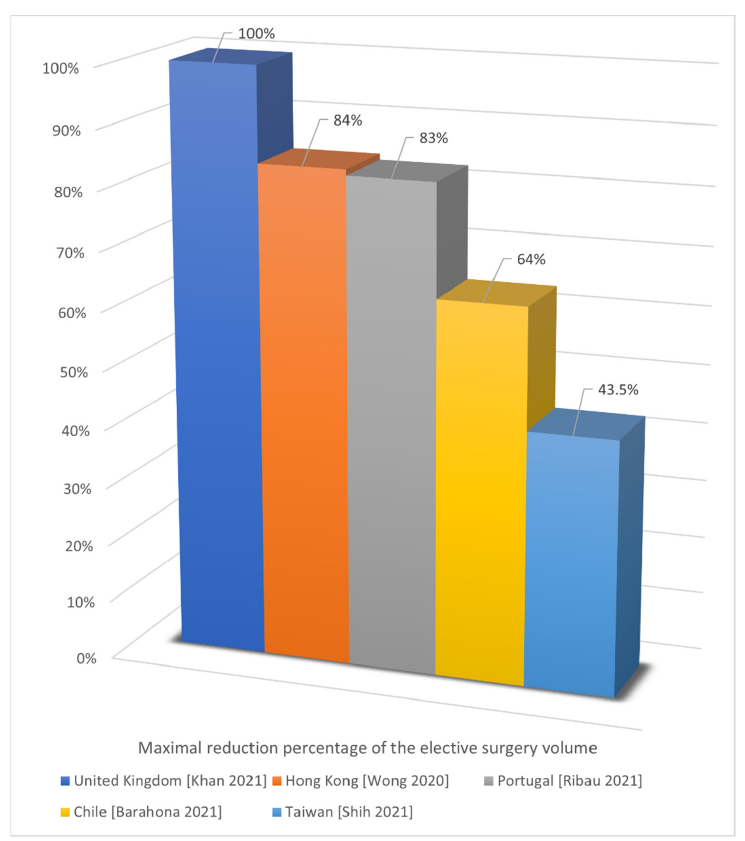
Figure 3. Maximal reduction in elective surgery performance.